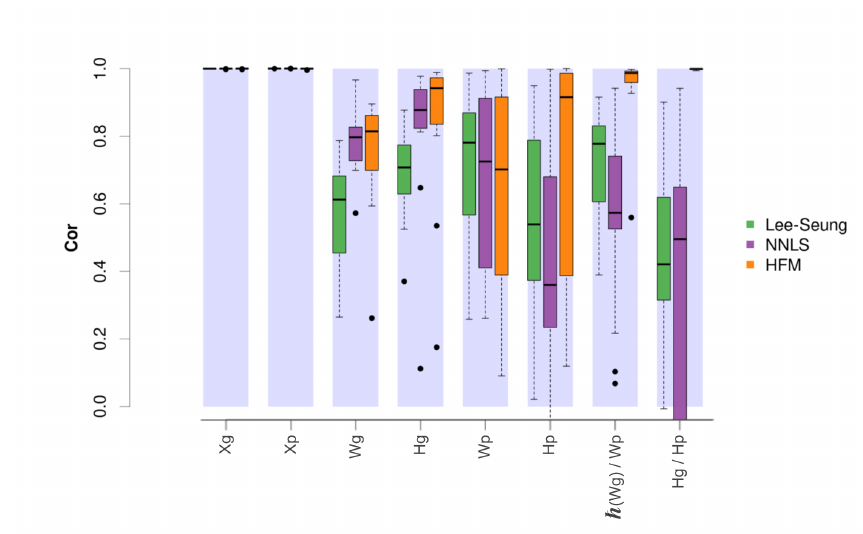
Figure 4. Distribution of the correlation values obtained between the simulated and the optimised matrices by using the original NMF, the alternating non-negative least squares method (NNLS) and the hierarchical factorisation model (HFM). As can be seen, the hierarchical model provides the highest correlations, especially when comparing the coherence between both sets of components ( W g vs. W p S T ) and their corresponding mixtures ( S T H g vs. H p